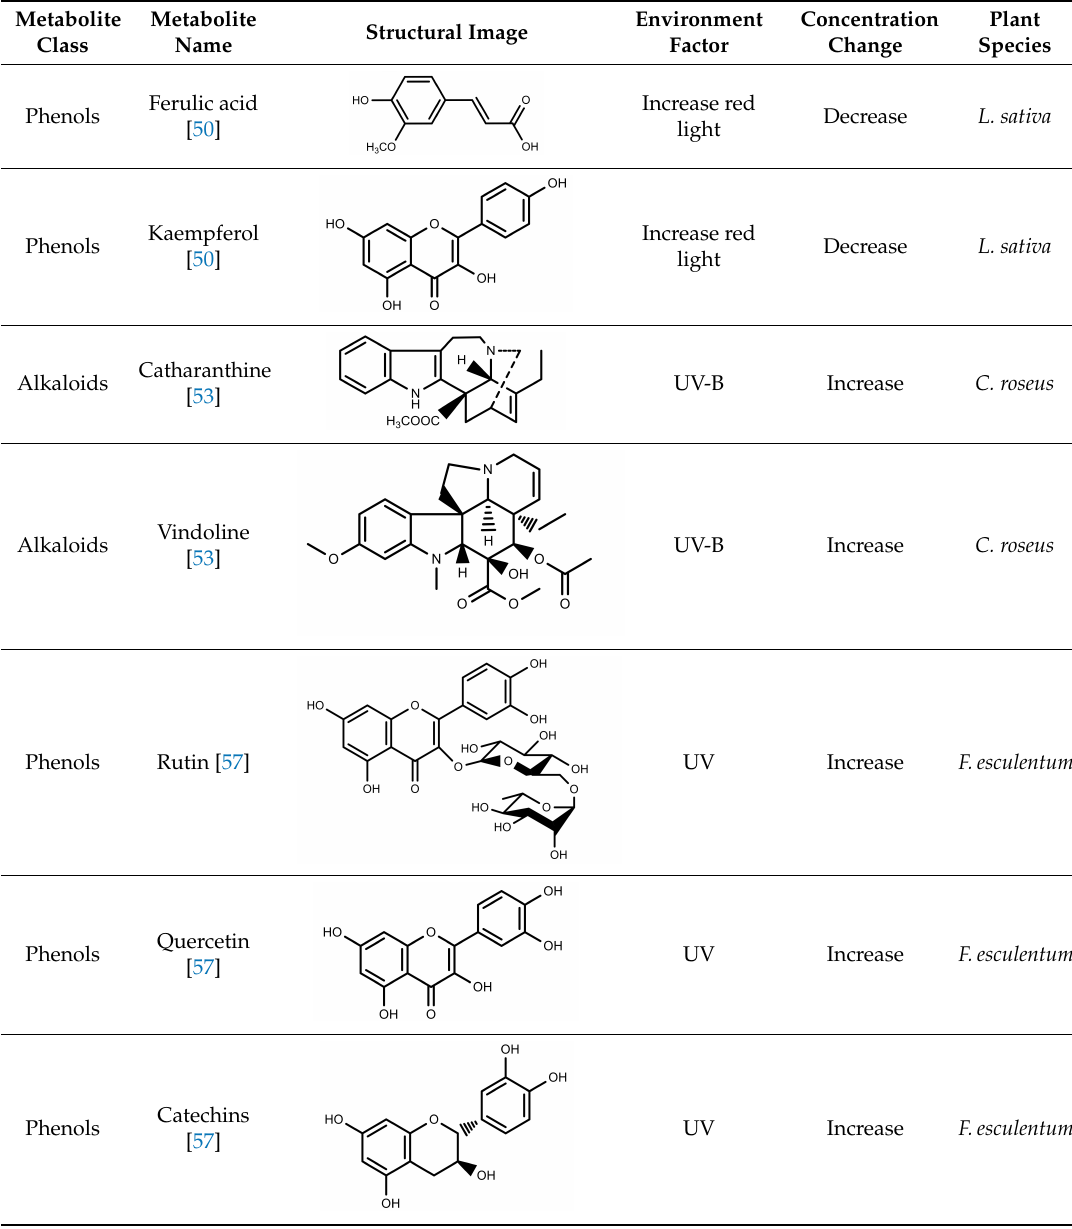
Table 3. Light quality change on the content of various plant